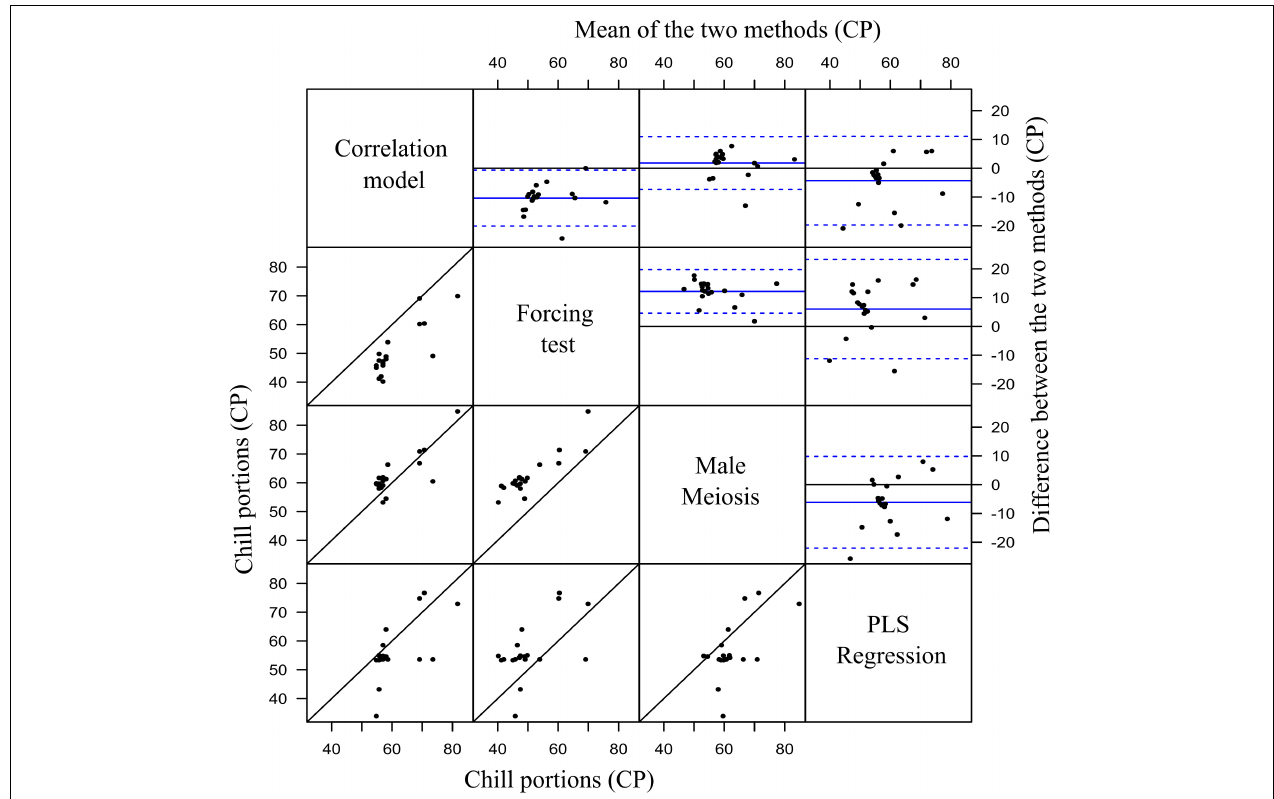
FIGURE 7 | Graphical methods for assessing variability and agreement in paired measurements of chill portion values obtained from four different methods. Scatter diagrams (lower-left grid) show the set of paired values in each pairwise comparison. Bland-Altman plots (upper-right grid) of the difference in chill portions of each value-pair against the mean of each value-pair. Blue horizontal lines show the mean difference (solid lines) and the superior and inferior limits of agreement ( ± 1.96 · SD), respectively (dotted